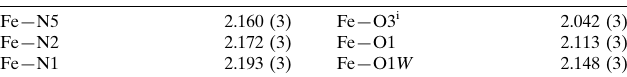
Selected bond lengths (A˚ ).